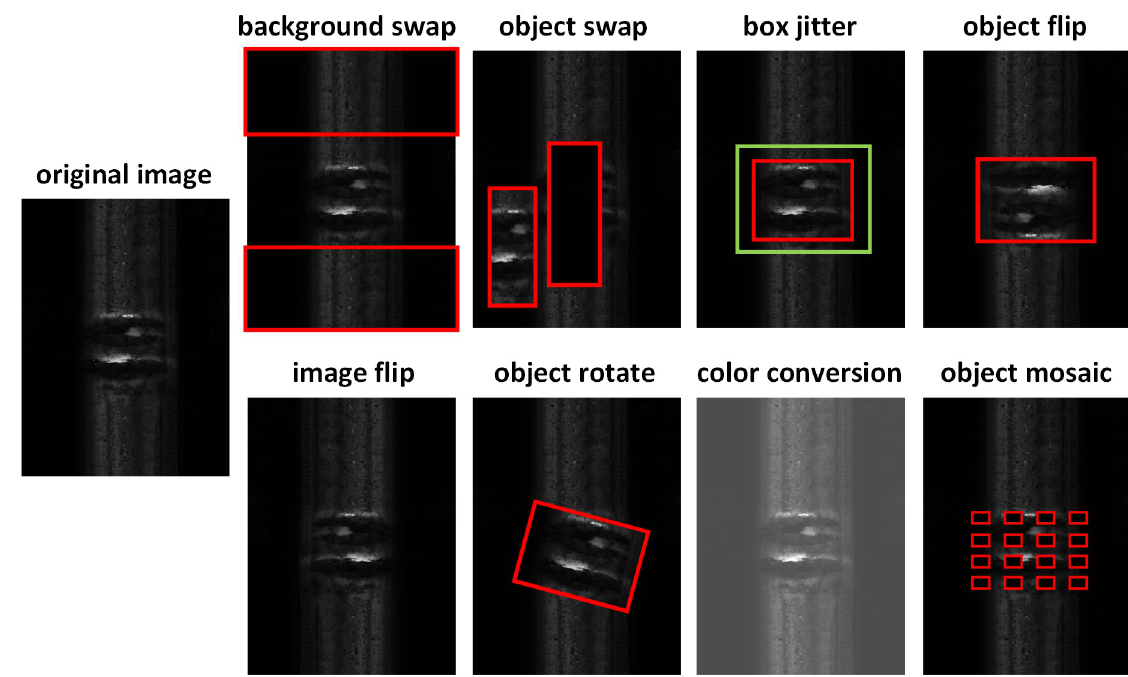
Fig 3. Image augmentation methods within